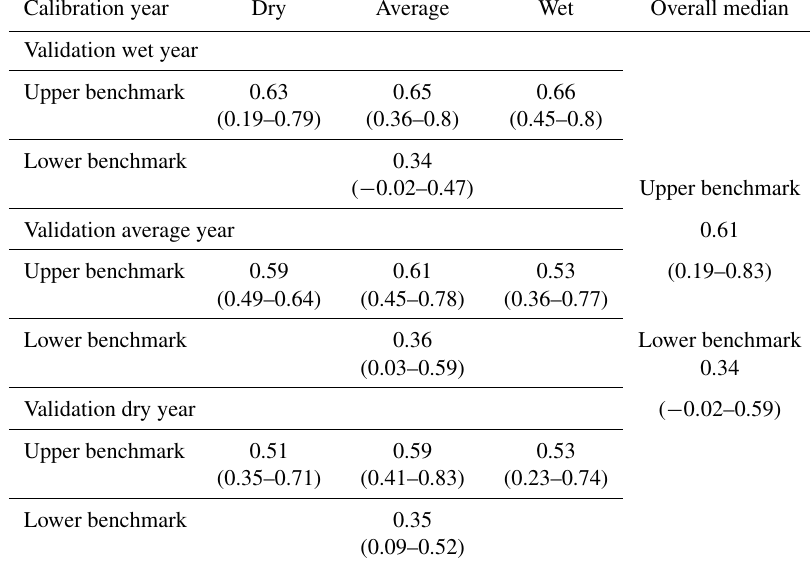
Table 4. Median and the full range of the overall consistency performance P OA scores for the upper benchmark (hourly FOEN data). The P OA values for the dry, average and wet calibration years were used as the upper benchmarks for the evaluation based on the year character (Figs. 6 and S2 in the Supplement); the values in the “overall median” column were used as the benchmarks in the overall median performance evaluation shown in Fig.